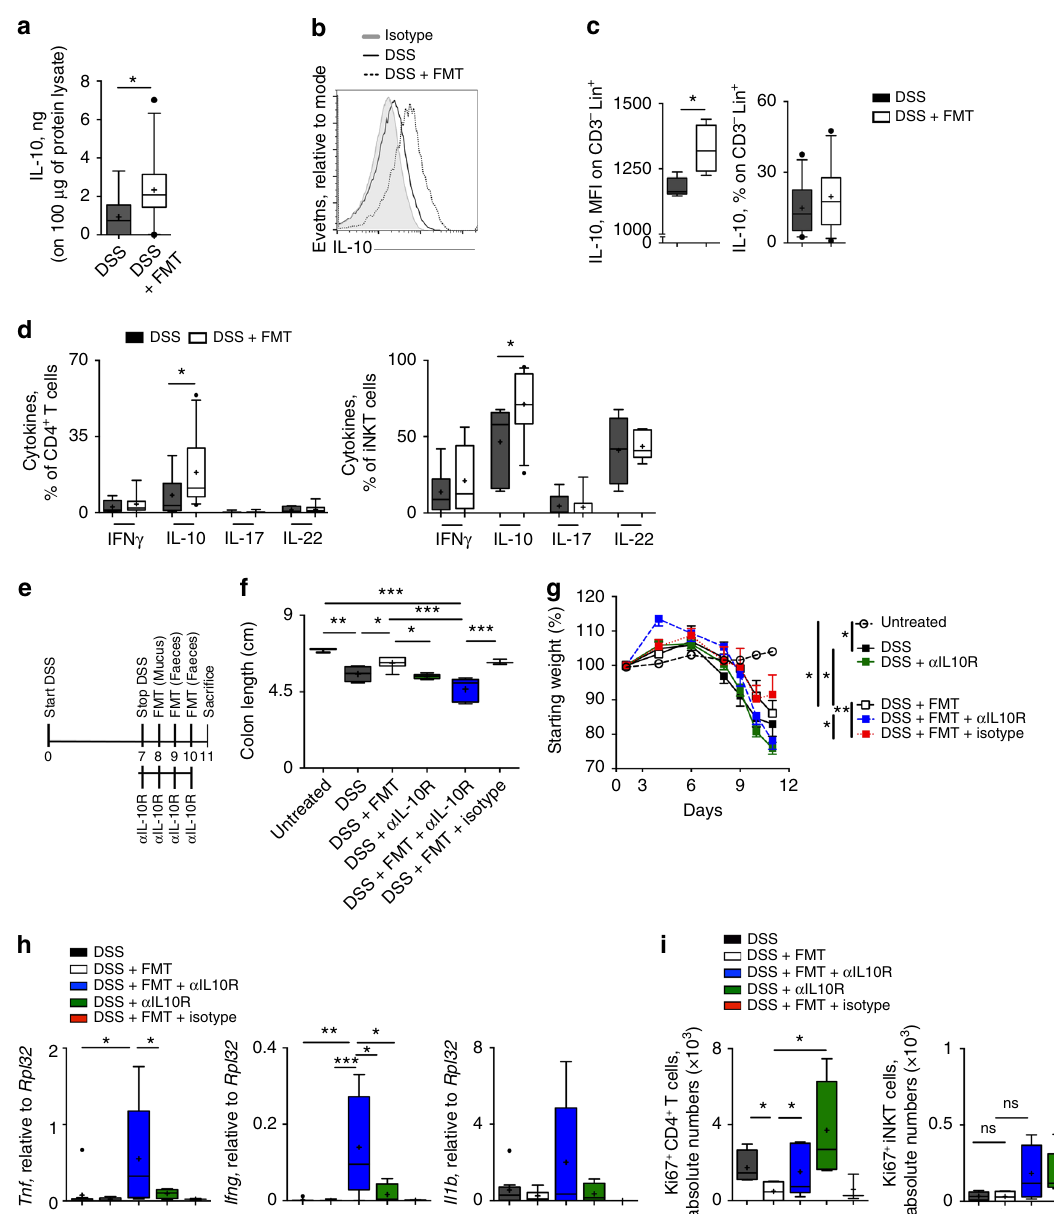
Fig. 7 IL-10 contributes to FMT bene fi cial therapeutic effects. a IL-10 colonic expression in DSS-(black boxes) and DSS + FMT-(white boxes) treated mice. b , c Representative histograms of IL-10 expression ( b ) and cumulative Mean fl uorescence intensity (MFI) ( c , left panel) and frequency ( c , right panel) of IL- 10-producing colonic professional APC (CD45 + CD3 − MHC-II + ) in DSS (black boxes) and DSS + FMT (white boxes) treated mice. d Summary of cytokines secreted by colonic CD4 + T cells and iNKT cells in DSS-treated (black boxes) and FMT-treated (white boxes) mice 11 days after starting DSS administration. e Schematic representation of the experiment. f , g Colon length ( f ) and weight loss ( g ) of untreated mice (white dotted boxes/open circles), or receiving DSS (black boxes/black symbols), or DSS + FMT (white boxes/white square symbols) or DSS + α IL-10R (green boxes/green symbols), or DSS + FMT + α IL-10R (blue boxes and blue symbols) or mice receiving DSS + FMT + α IL-10R isotype antibody (red boxes/red symbols). h Colonic expression of Tnf, Ifn γ and IL1 β in DSS (black boxes), DSS + FMT (white boxes), DSS + α IL-10R (blue boxes), DSS + FMT + α IL-10R- (green boxes) and DSS + FMT + α IL-10R-isotype-antibody-treated mice (red boxes). i Absolute numbers of KI67 expressing colonic CD4 + T cells (left panels) and iNKT cells (right panels) in DSS (black boxes), DSS + FMT (white boxes), DSS + α IL-10R (blue boxes), DSS + FMT + α IL-10R (green boxes) and DSS + FMT + α IL-10R isotype antibody (red boxes). Statistical signi fi cance was calculated using a Mann – Whitney test for comparison within two groups or Kruskal – Wallis test with Dunn ’ s multiple comparison correction within more than two groups. * P < 0.05, ** P < 0.01, *** P < 0.001 were regarded as statistically signi fi cant. Outliers were detected with Grubb ’ s test. Non parametric distributions were represented as median + /- interquartile range. In Box and whiskers plots, centre line represents median; cross, represents mean; dots represent outliers. In ( a ) DSS n = 15,DSS + FMT n = 26. In ( b – d ) DSS n = 14,DSS + FMT n = 17. In ( e – i ) DSS, DSS + FMT n = 4; DSS + α IL-10R,DSS + FMT + α IL-10R n = 5, DSS + FMT + isotype n =